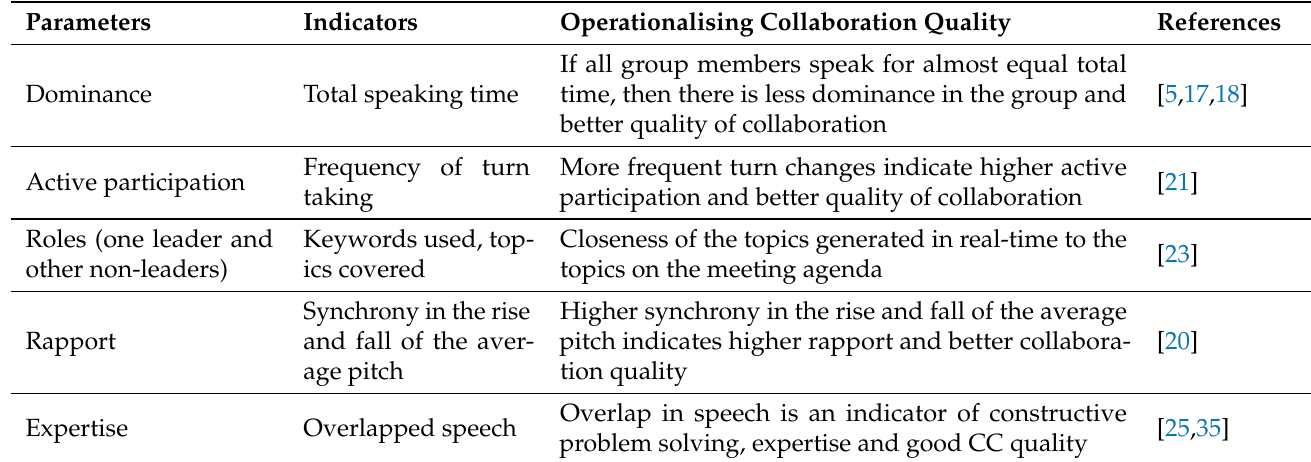
Table 1. Indicators of collaboration and its